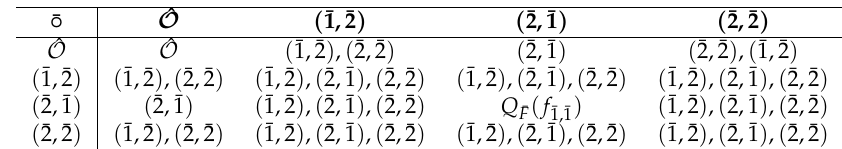
(cid:0) ( f ¯1,¯1 ) , ¯ ◦ (cid:1) Q ¯ Z 5